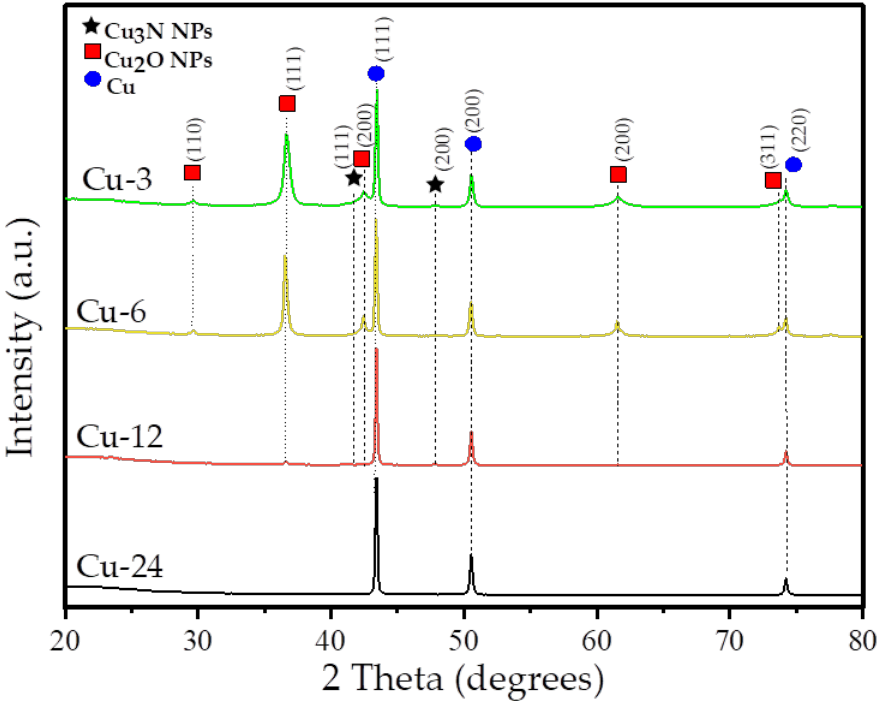
Figure 1. PXRD patterns of the